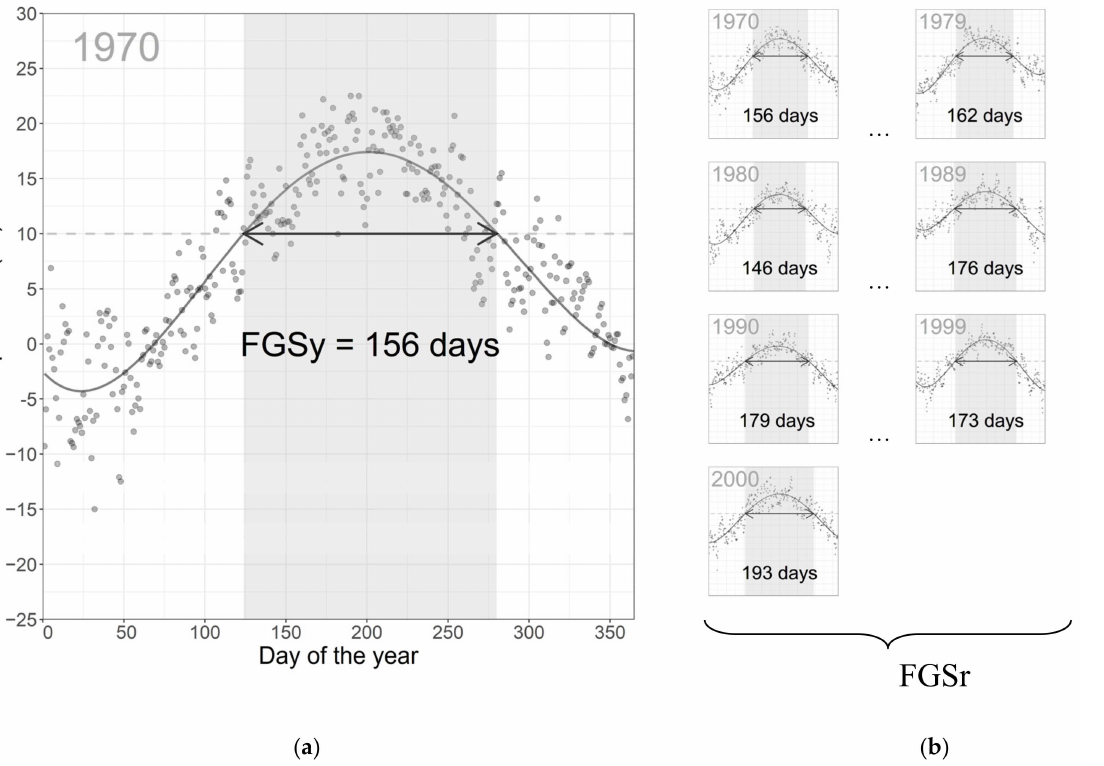
Figure 1. Graphical illustration of the method of determining the ‘yearly’ length of the forest growing season (FGSy) for the station BIERU ´N STARY in year 1970 on the basis of mean daily air temperatures ( a ) and an illustrative diagram of the calculation of the ‘real’ length of the forest growing season (FGSr) for the period 1970–2000 ( b